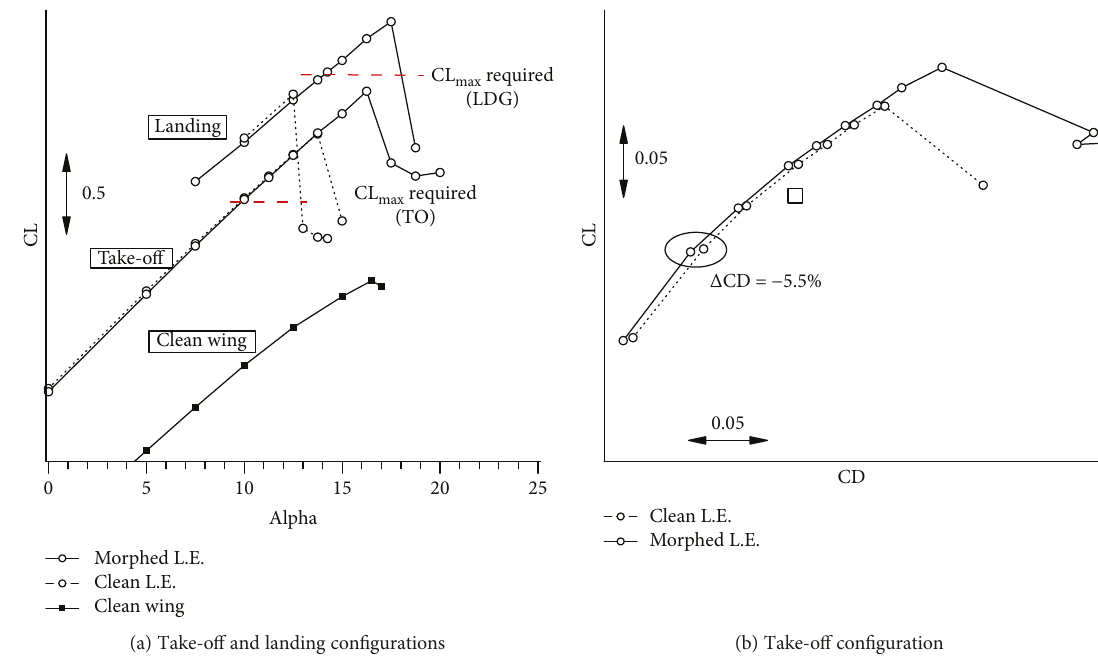
Figure 29: E ff ect of a droop nose on the performance in high-lift conditions.